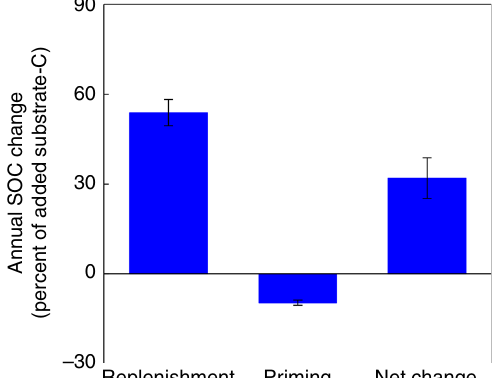
Fig. 2 Synthesis of annual SOC change induced by replenishment and priming, and the consequent net SOC change with a one-time new C addition at the beginning. The magnitude of replenishment is signi fi